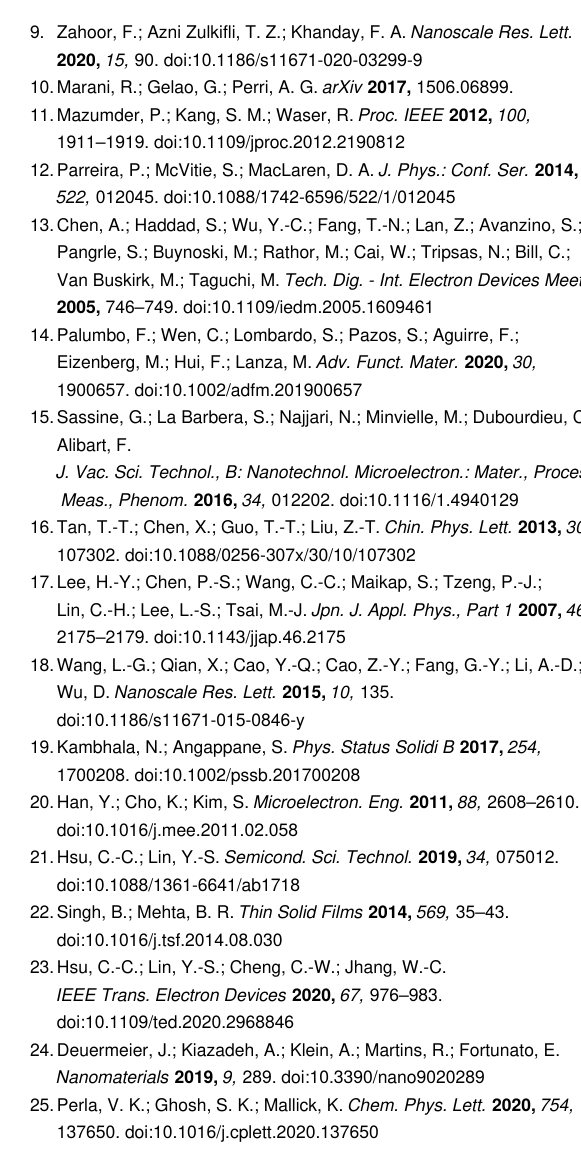
Figure 9: Schematic illustration of energy level diagrams of the prepared Au/(Ti–Cu)Ox/Ti6Al4V structure. The change in material composition in the film is marked by red lines.